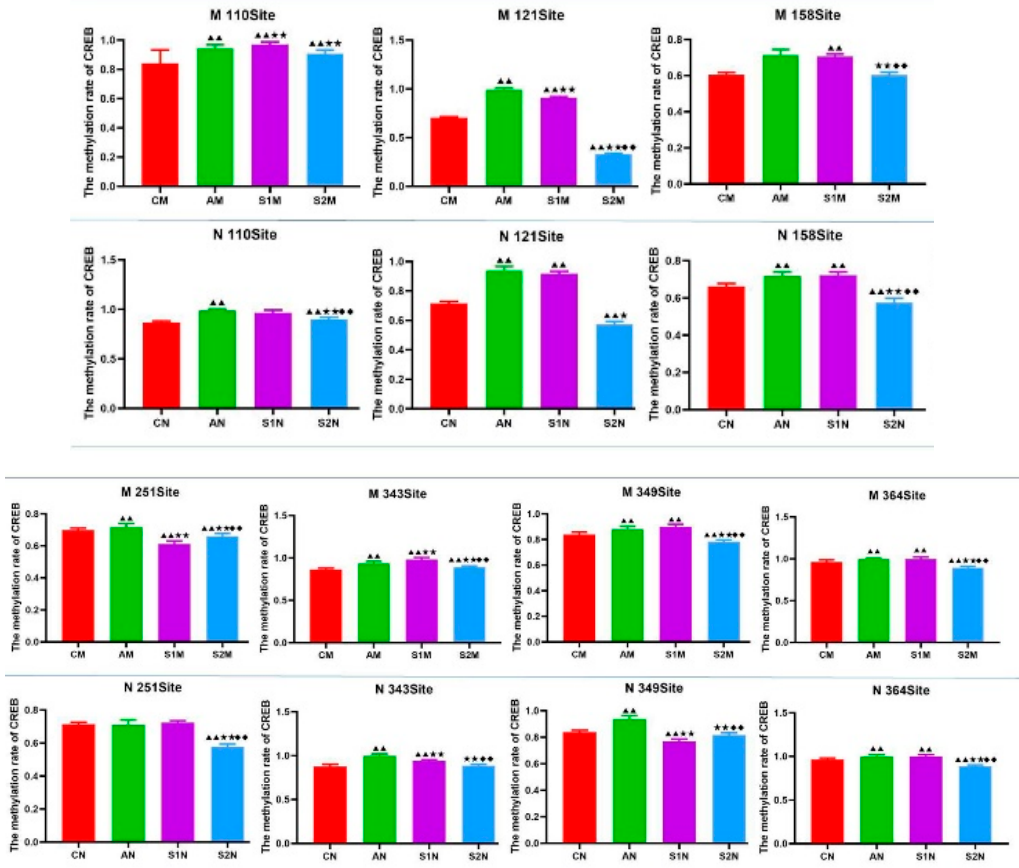
Figure 9. Comparison of DNA total methylation rate at each of the 7 sites of CREB gene in rat hippocampus under various treatment conditions. The fragment containing nucleotide 56–470, with concentrated CpG sites, was selected as the target sequence. Data are presented as Mean ± SD ( n = 10/group). The in-graph symbols indicate: ▲ p < 0.05, ▲▲ p < 0.01 versus group CM or CN; * p < 0.05, ** p < 0.01 versus group AM or AN; and ◆ p < 0.05, ◆◆ p < 0.01 versus group S1M.